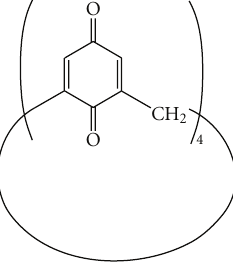
Scheme 8: Structure of calix-[4]-quinone.